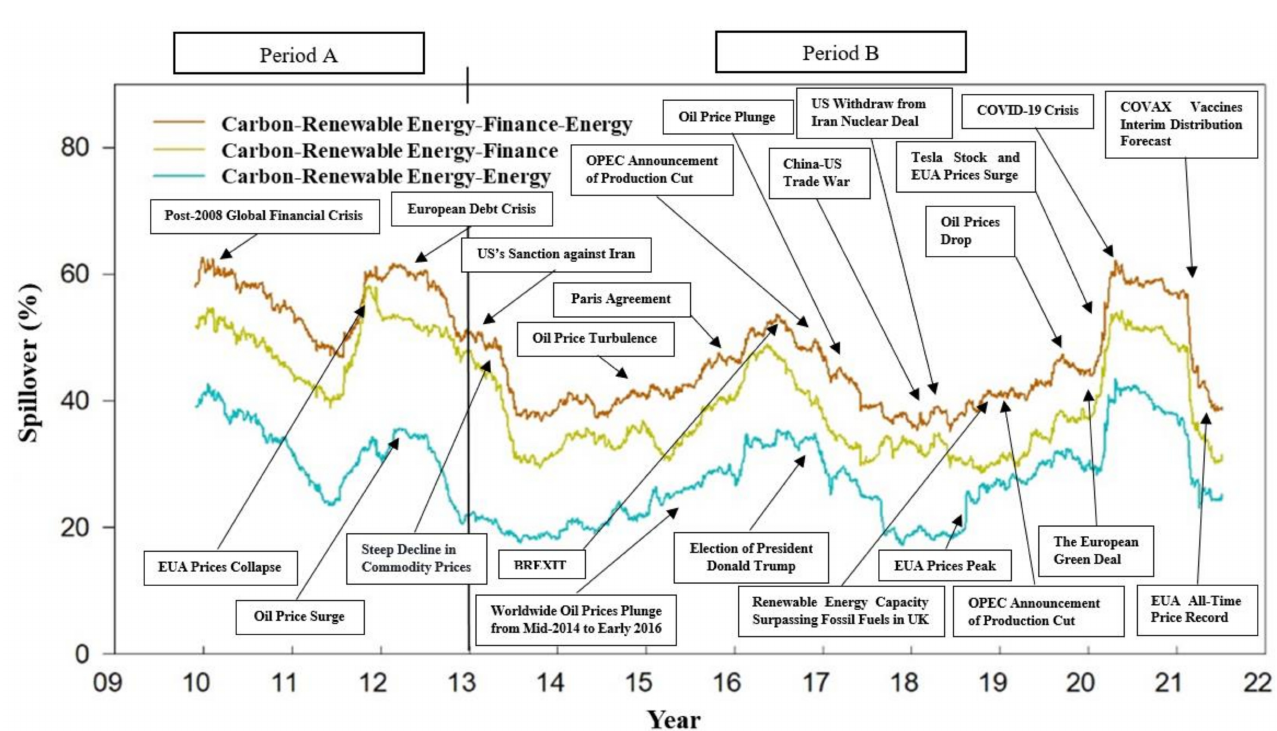
Figure 6. Spillover Plot of Total Spillover Indexes, Robustness Check. Note: We plot the time series of the total return spillover indexes of “Carbon-Renewable Energy-Finance-Energy”, “Carbon-Renewable Energy-Finance” and “Carbon- Renewable Energy-Energy” market systems based on 252-day rolling samples for the period from 1 December 2009 to 8 July 2021. The underlying variance decompositions are based on VAR models with lag orders of 8, 8 and 7. The forecast horizons are all 5 days. In the plot, we also mark the major market and political events during the studied